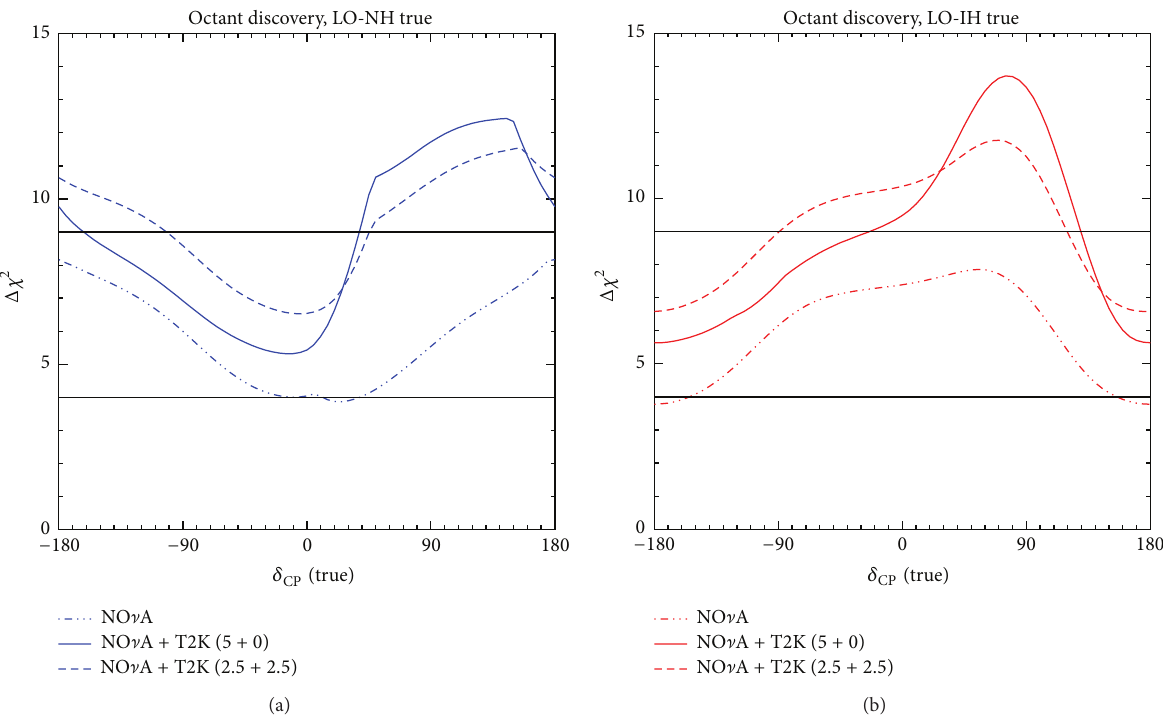
Figure 9: Octant resolving capability as a function of true 𝛿 for various setups. In these plots, LO is assumed to be the true octant. The left CP (right) panel corresponds to NH (IH) being the true hierarchy. This figure has been taken from